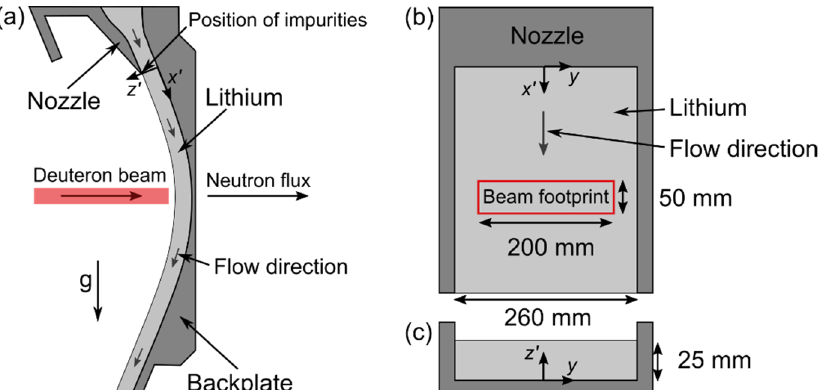
Figure 1. Sketch of the liquid lithium target in DONES. ( a ) Side view on the cross-section through the channel center. ( b ) Front view. ( c ) Cross-section perpendicular to the flow direction at the nozzle outlet. The coordinate axes are y for the channel width, x’ parallel to the channel floor in streamwise direction and z’ perpendicular to the channel floor. The origin is at the nozzle outlet.